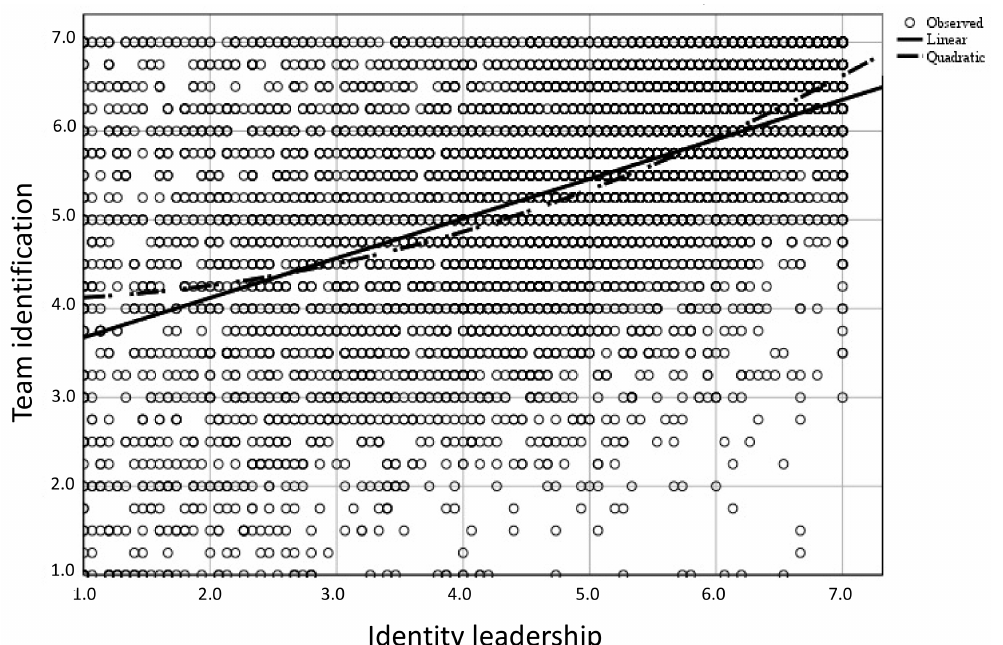
Figure 3. Curve estimation of the relation of identity leadership and team identification.